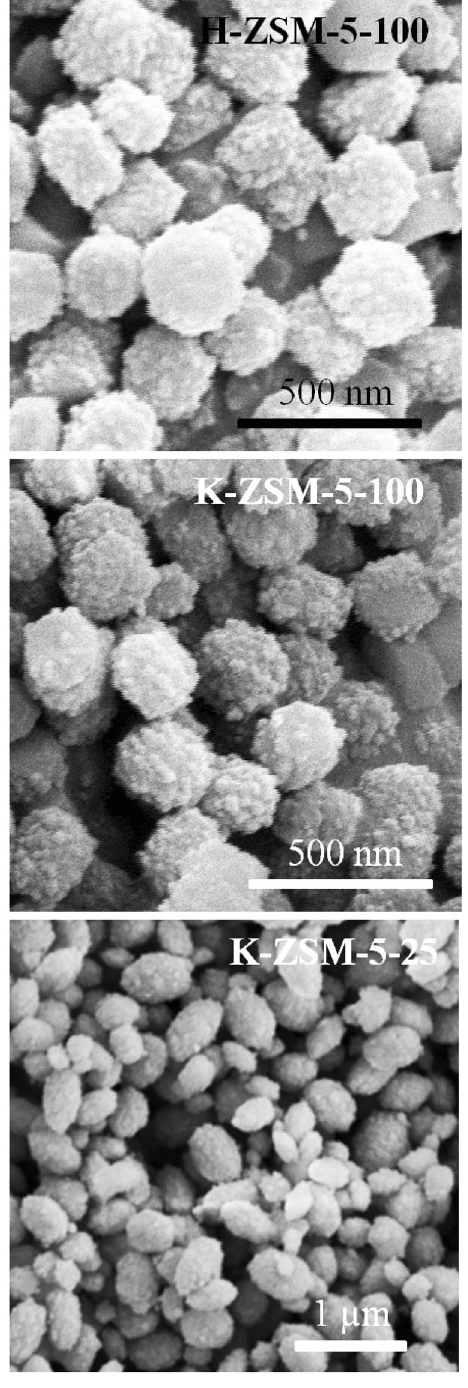
Figure 2. SEM images of the